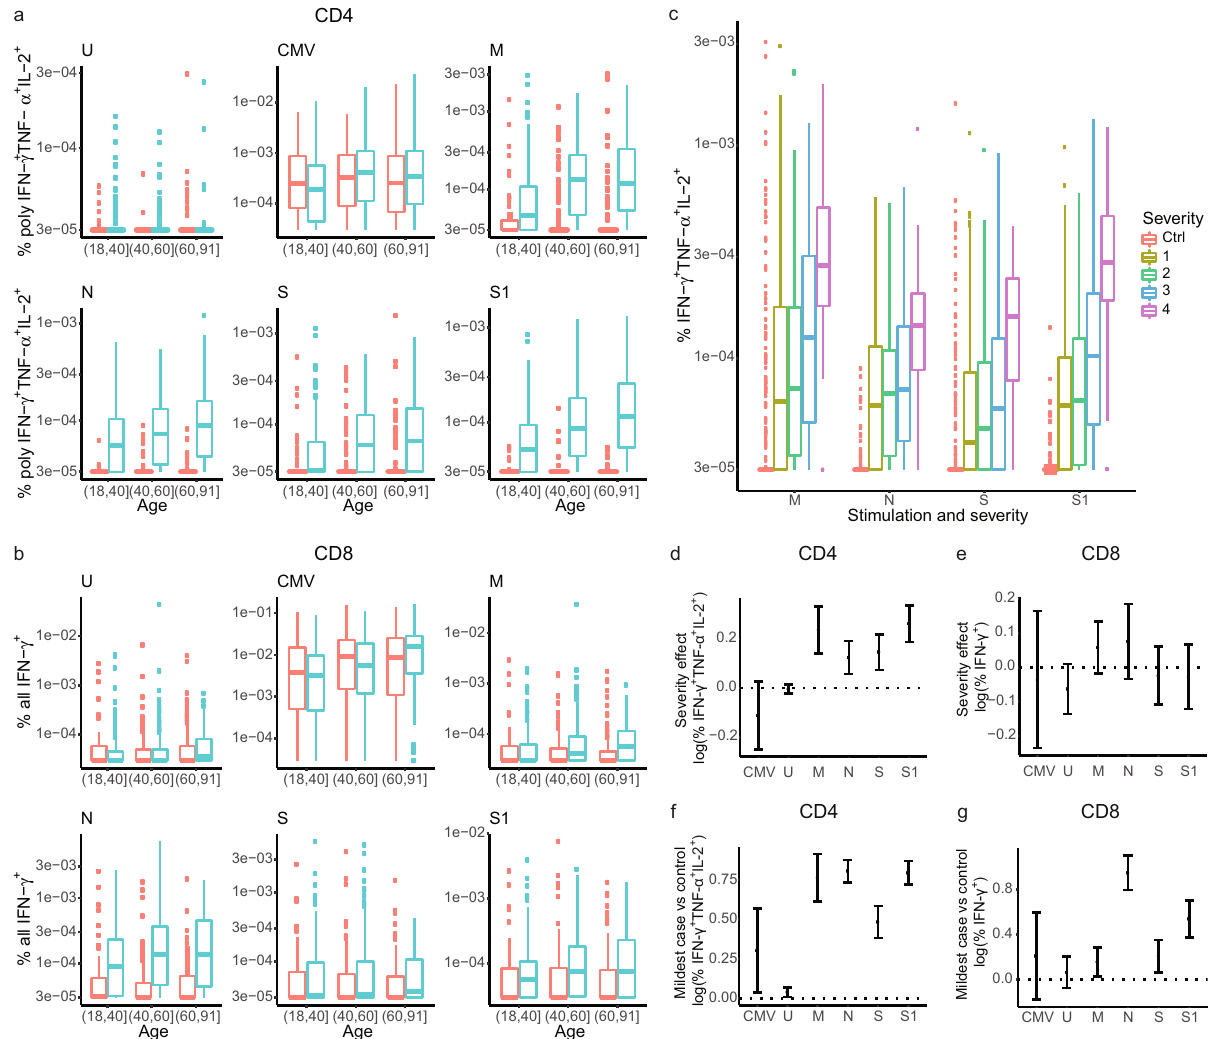
Fig. 3 SARS-CoV-2 reactive CD4 + T-cell responses correlate with age and disease severity while CD8 + T-cell responses only correlate with age. Box plots showing the correlation between SARS-CoV-2 reactive a polyfunctional CD4 + as well as b all IFN- γ + CD8 + T-cells and age. Frequency of cytokine secreting T-cells (as indicated on the Y-axis) and age (that was split into age bins as indicated on the X-axis) following different stimulations (as indicated above each plot). Uninfected controls are displayed in red (for CD4 + : n 18 – 40 = 64, n 40 – 60 = 166, and n 60 – 91 = 160, for CD8 + : n 18 – 40 = 65, n 40 – 60 = 165, and n 60 – 91 = 155) and SARS-CoV-2 cases in blue (for CD4 + : n 18 – 40 = 300, n 40 – 60 = 328, and n 60 – 91 = 114, for CD8 + : n 18 – 40 = 300, n 40 – 60 = 327, and n 60 – 91 = 113). c Box plots show the correlation of polyfunctional CD4 + T-cell responses (Y-axis) with disease severity (indicated by the different colors) upon different stimulation conditions (X-axes). For comparison, we show the response induced by each stimulation condition in the uninfected controls (ctrl, n = 392). The frequency of polyfunctional CD4 + T-cell responses in SARS-CoV-2-infected individuals were grouped into four severity groups based on data from questionnaires and/or medical records. 1: Asymptomatic/mild ( n = 208); 2: moderate ( n sampes = 140); 3: severe ( n = 167); 4: hospitalized ( n = 30) ( b ). The bottom and top of the boxes correspond to the 25th (Q1) and 75th (Q3) percentiles, the line inside the box corresponds to the median, and the whiskers are located at max(min(Expression), Q1 – 1.5 IQR) and min(max(Expression), Q3 + 1.5 IQR), respectively (where IQR is the interquartile range = Q3 – Q1). d , e Estimates for differences in the logarithm of the percentage of d polyfunctional CD4 + T-cells out of all CD4 + T-cell responding to the different stimulation conditions between unit of the severity scale of the cases and same is shown for e all IFN- γ + CD8 + T-cells for controls ( n = 387), 1: Asymptomatic/mild ( n = 207); 2: moderate ( n sampes = 139); 3: severe ( n = 167); 4: hospitalized ( n = 30). f Difference in the logarithm of the percentage of polyfunctional CD4 + T-cells out of all CD4 + T-cell responding to the different stimulation conditions between cases with the mildest disease severity ( n = 208) and uninfected controls ( n = 392). g Difference in the logarithm of the percentage of polyfunctional CD8 + T-cells out of all CD8 + T-cell responding to the different stimulation conditions between cases with the mildest disease severity ( n = 207) and uninfected controls ( n = 387). The error bars indicate 95% con fi dence intervals (CI). See also Tables S2 and S3. Association between T-cell responses in different groups was tested by linear regression and signi fi cance was assessed with the standard linear regression t -test.